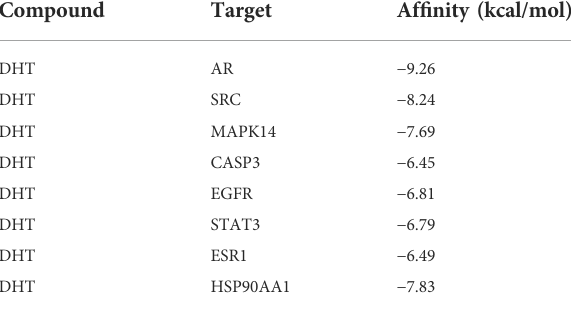
TABLE 2 Molecular interactions between the core targets and DHT.